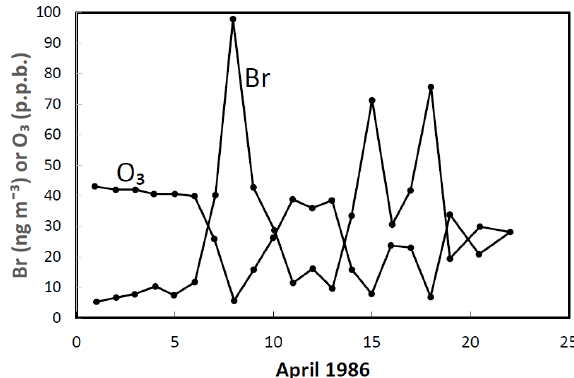
Figure 12. A comparison of daily mean ground-level O 3 and filter- able Br − concentrations at Alert, Canada, in April 1986 illustrating the strong inverse correlation between the two chemicals. Adapted from Barrie et al.